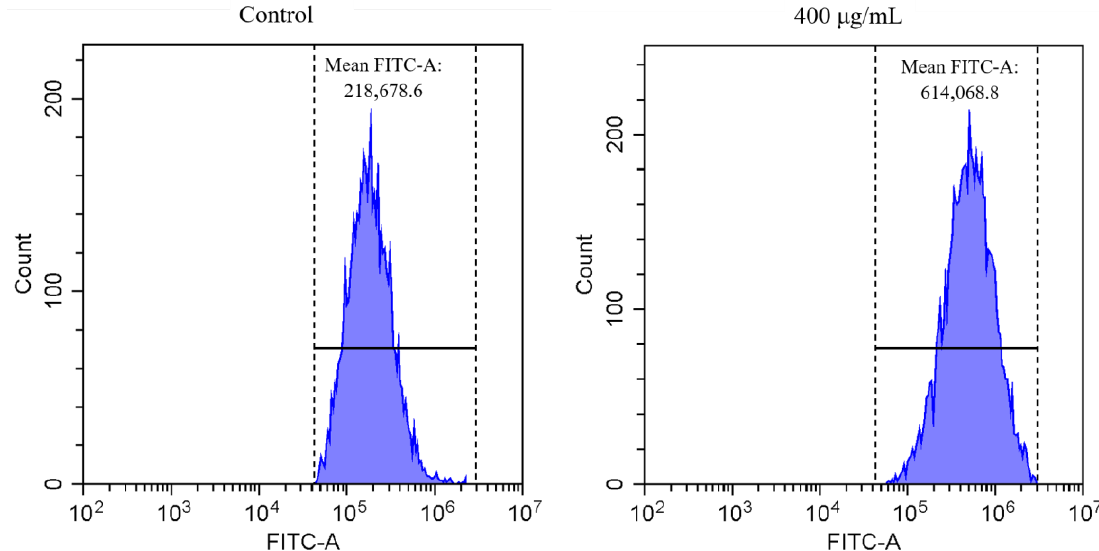
Figure 5. Representative histograms of ROS determination by flow cytometry (the winter sample). Mean FITC-A is the statistical peak area of cell fluorescence stained by the fluorescent probe DCFH-DA.